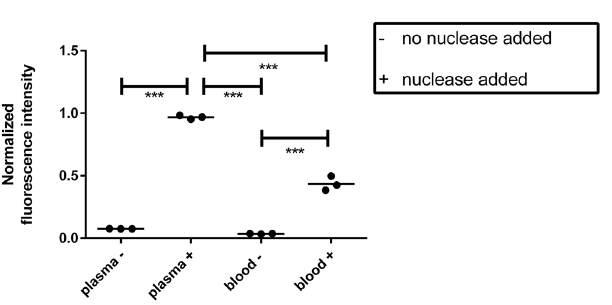
Figure 2. Normalized fluorescence intensity after probe incubation in human blood and plasma. Horizontal line represents the mean. – indicated no nuclease was added. + indicates nuclease was added. ** Indicates P < 0.001, *** indicates P < 0.0001.